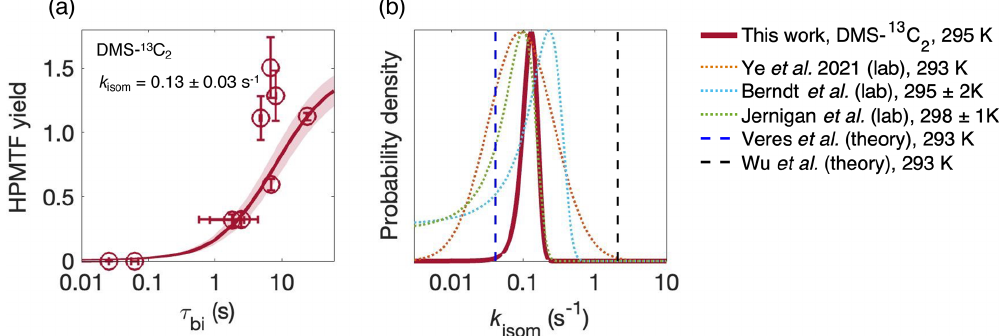
Figure 3. (a) The yield of HPMTF in the abstraction channel as a function of the bimolecular lifetime τ bi of CH 3 SCH 2 OO from the DMS- 13 C 2 data. The shaded area is 1 σ of the fit, which takes into account uncertainty in both τ bi (arising from errors in [NO] and [HO 2 ]) on the x axis, and instrument noise on the y axis. Uncertainty in the CIMS sensitivity to HPMTF affects the absolute measurements but not the inflection point of the curve or the derived value of k isom . (b) Comparison of k isom from this work with previous determinations of k isom